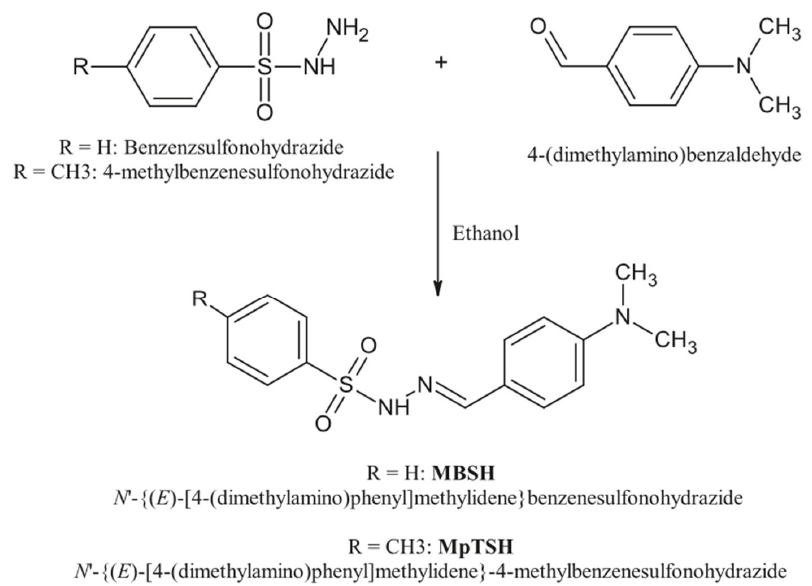
Figure 1. The synthetic pathways of the newly synthesized MBSH and MpTSH corrosion inhibitors (Ichchou et al., 2019). Reproduced with permission from [34]. Both inhibitors were found to be good corrosion inhibitors for carbon steel applica ‐ tions in HCl solution with maximum efficiency of 93.1% and 90.7% for MpTSH and MBSH, respectively. MpTSH showed better performance due to higher values of E HOMO , electron affinity, softness, electrophilicity, number of electrons transferred and lower val ‐ ues of ET, energy gap, E LUMO , ionization energy, electronegativity, dipole moment, and hardness, compared to MBSH. All in all, both inhibitors displayed a mixed type behavior that followed Langmuir adsorption isotherm. Moreover, their inhibition efficiency in ‐ creased with their concentration but decreased with increasing temperature.